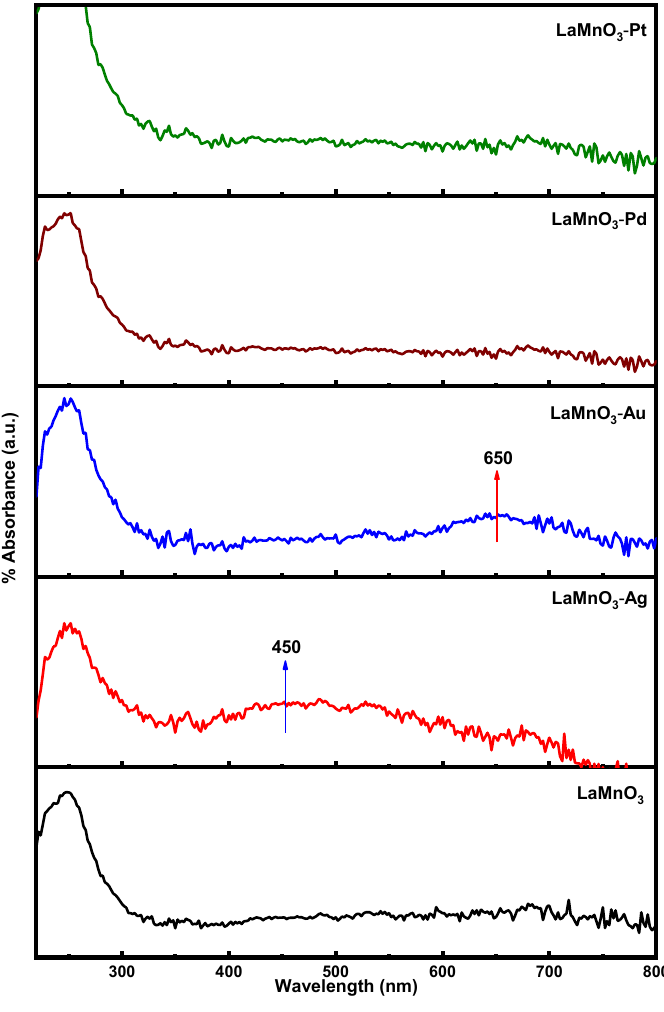
Figure 6. DR UV-vis spectra for the synthesized samples.